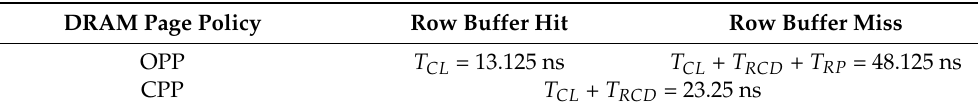
Table 1. Memory access latency in two-page policy